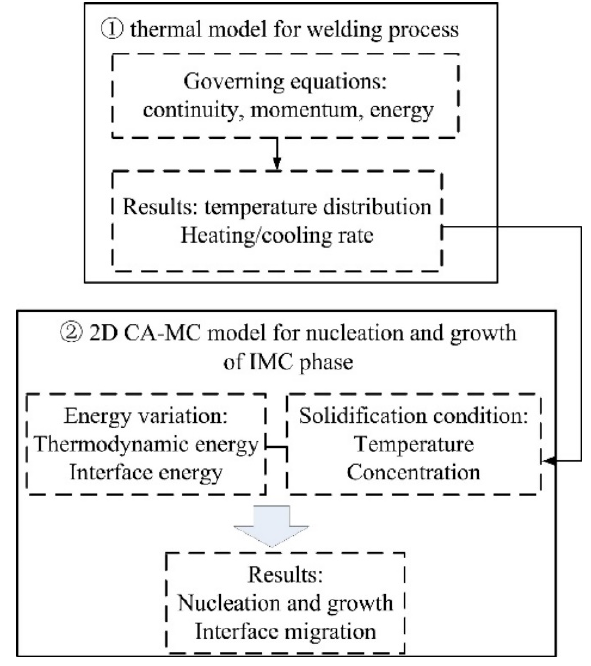
Figure 3. Flow chart of the CA-MC model. The interfacial microstructures were mapped onto a 2D hexagonal lattice. The orien-